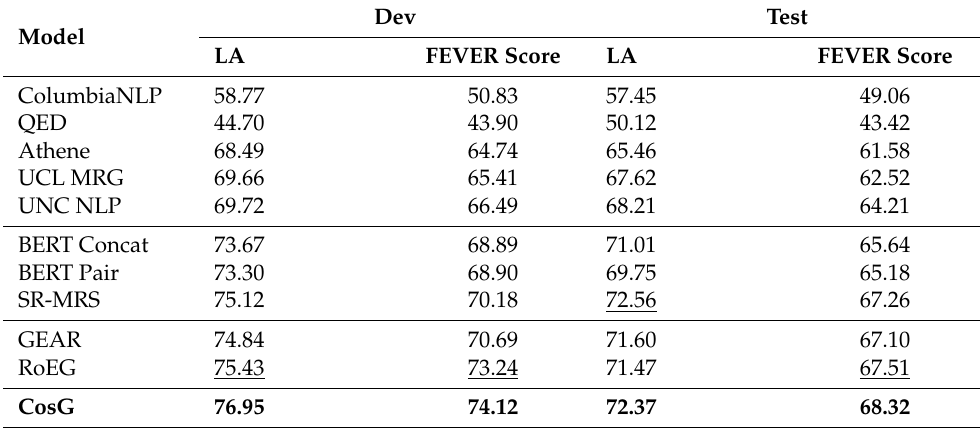
Table 3. Overall performance (%) on the development (dev) set and the bind test set. The re- sults produced by the best baseline and the best performer in each column are underlined and boldfaced,